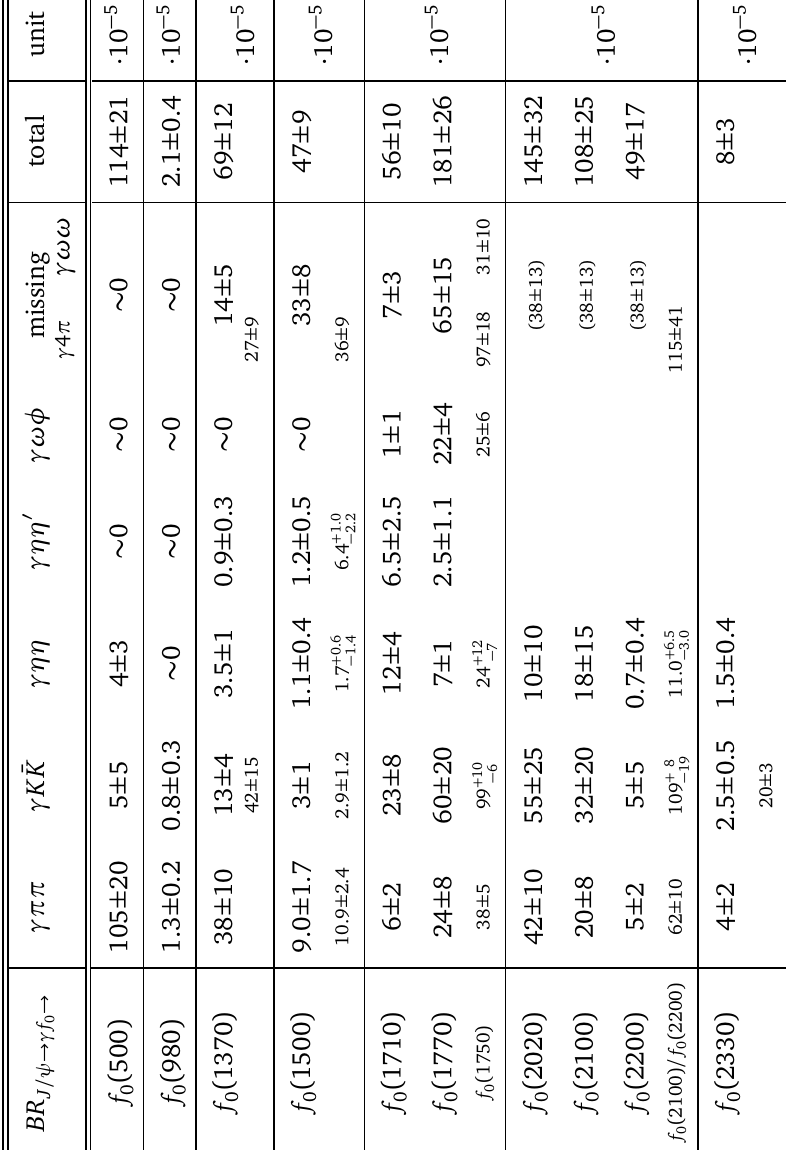
Table 2: J /ψ radiative decay rates in 10 − 5 units. Small numbers represent the RPP values, except the 4 π decay modes that gives our estimates derived from [ 22, 23 ] . The RPP values and those from Refs. [ 22, 23 ] are given with small numbers and with two digits only; statistical and systematic errors are added quadratically. The missing intensities in parentheses are our estimates. Ratios for K ¯ K are calculated ( 1750 ) we quote results listed K from K by multiplication with a factor 4. Under f S S 0 ( 1710 ) , f ( 1750 ) and f ( 1800 ) . The RPP values should be in RPP as decays of f 0 0 0 ( 1710 ) and f ( 1770 ) . BES [ 19 ] uses two compared to the sum of our yields for f 0 0 ( 1710 ) and f ( 1790 ) and assigns most of the K ¯ K intensity to scalar resonances, f 0 0 ( 1710 ) . Likewise, the yield of three states at higher mass should be compared to f 0 ( 2100 ) or f ( 2200 ) the RPP values for f 0 0